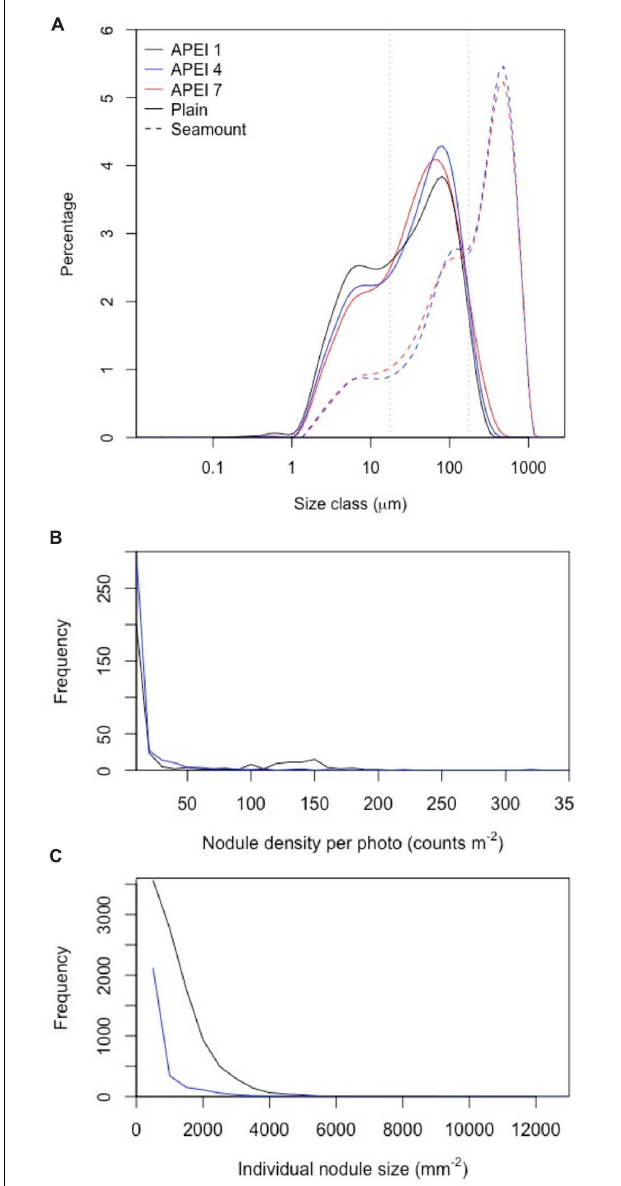
FIGURE 4 | Distributions of particle and nodule parameters at the study sites in the three APEIs in the western CCZ. (A) Particle size distributions in sediments collected in cores (0–5 cm horizon) on the plain and seamounts. Grey dotted lines indicate size divisions between fine, intermediate and coarse particles (17.5 and 174 µ m). (B,C) Distribution of nodule density (per image) and nodule size in APEIs 1 and 4.